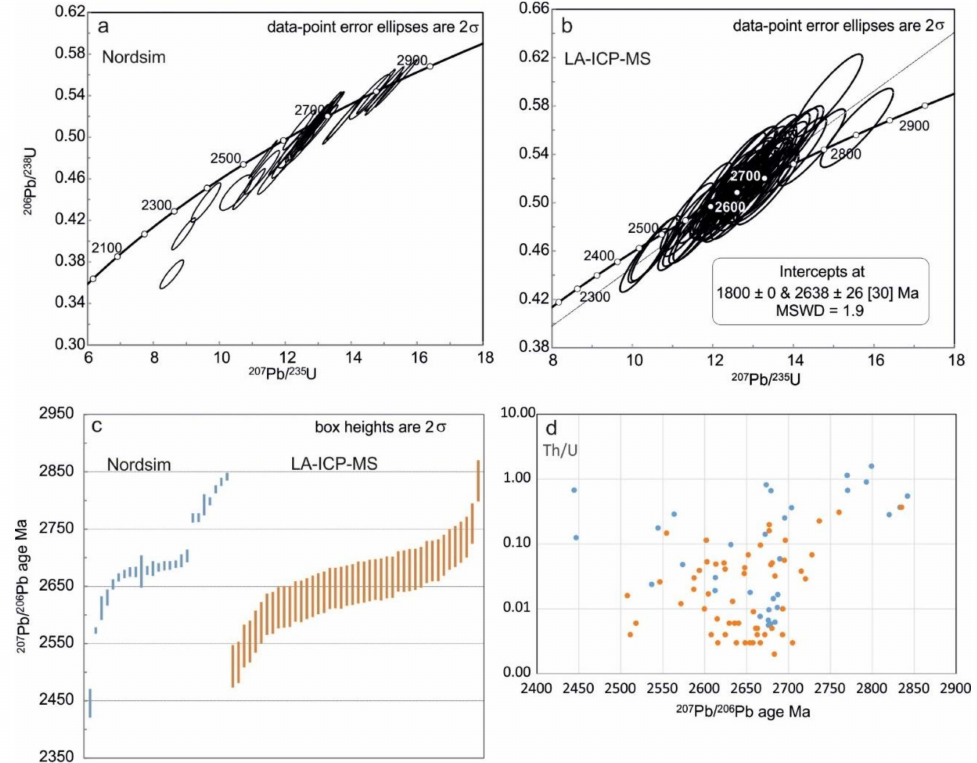
Figure 8. A concordia diagram for zircon grains in the sample A1843, analysed by SIMS ( a ) and LA-ICP-MS ( b ); ( c ) the distribution of the concordant 207 Pb / 206 Pb ages in Ma; ( d ) Th / U ratios of the analyzed zircon grains, blue dots = SIMS data, orange dots LA-ICP-MS